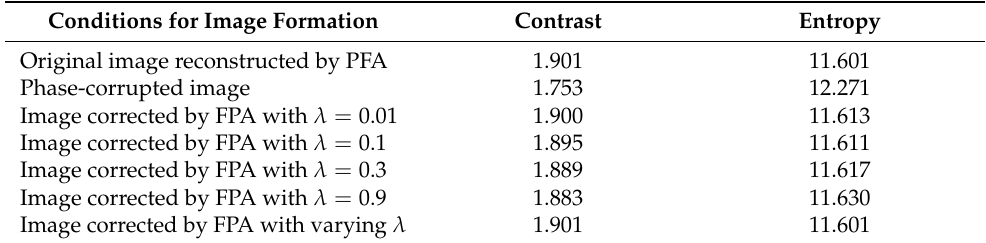
Table 1. Quality of the images with different conditions.